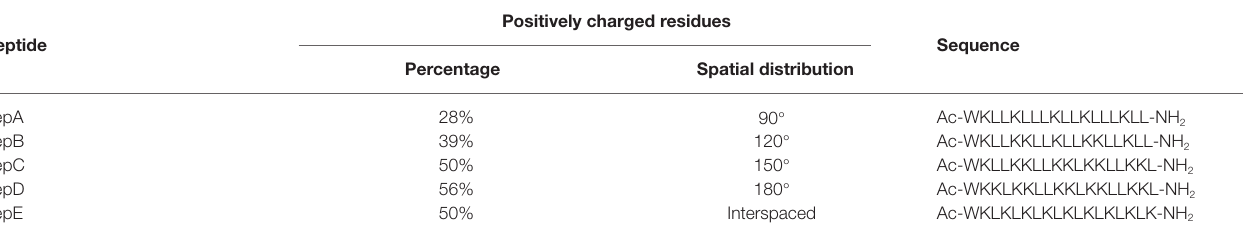
TABLE 1 | Peptides with different designs of the spatial distribution of positively charged residues.